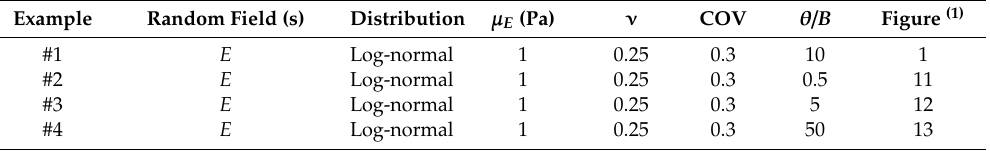
as ρ predicted / ρ (cid:48)(cid:48) actual (cid:48)(cid:48) − 1 is also given in each chart (see secondary vertical axis; a positive value indicate design on the safe side and vice